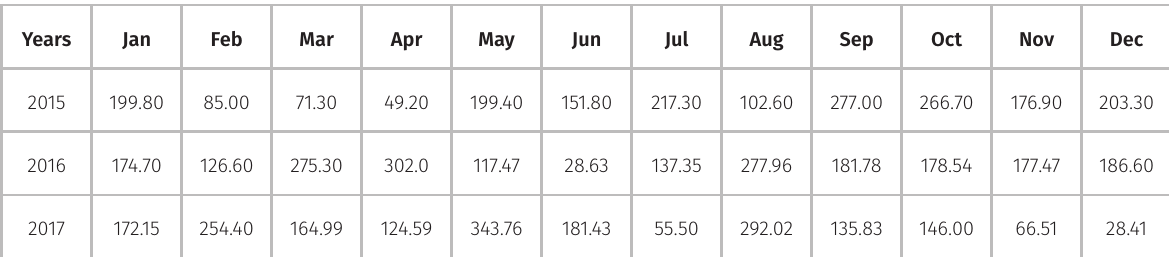
Table III. Monthly precipitation, in ml, from 2015 to 2017 at the Estação Experimental Cascata (EEC). Pelotas, RS,